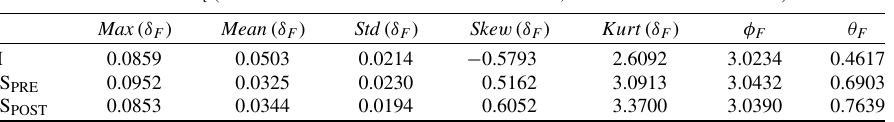
Table 5 Parameters in Healthy (H), Post-stroke subjects before (PS PRE ) and after (PS POST ) the robot-aided rehabilitation, for direction N t (units column 1–3 and column 6–7: radians; column 4–5: